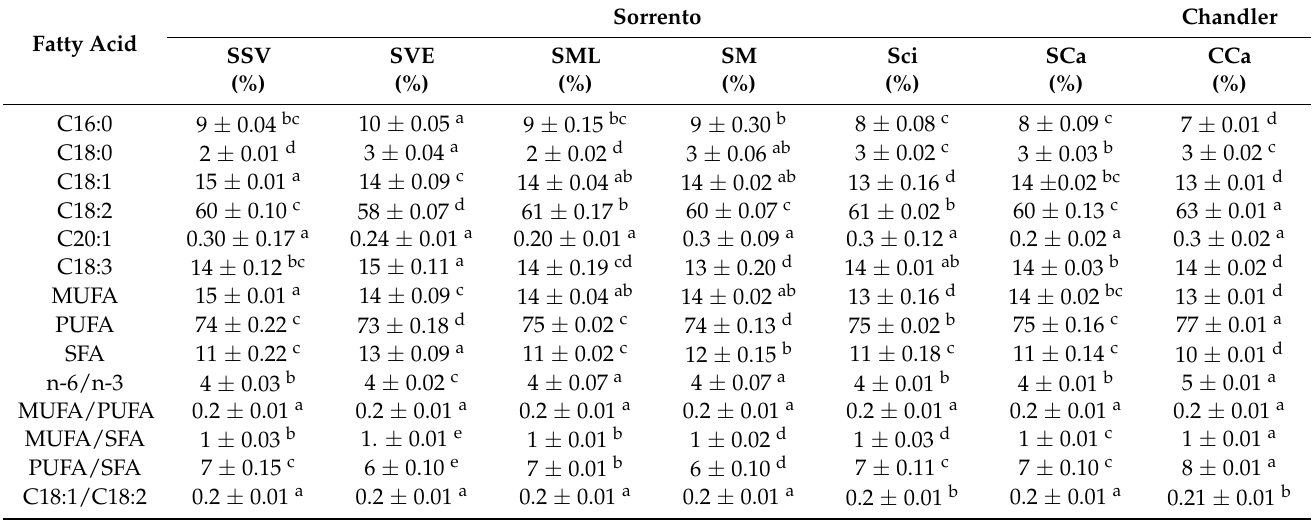
Table 5. Fatty acid profile of kernel ( n =